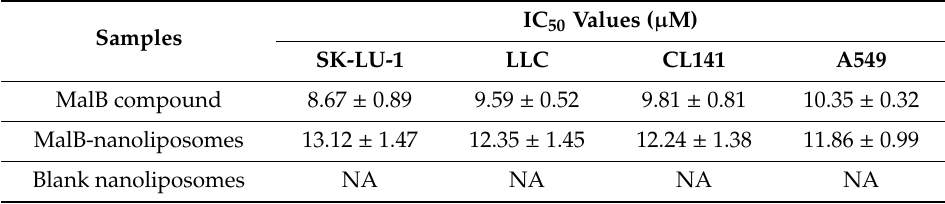
Table 3. Cytotoxic activities of malB-nanoliposomes and untrapped compound malB on di ff erent lung cancer cell